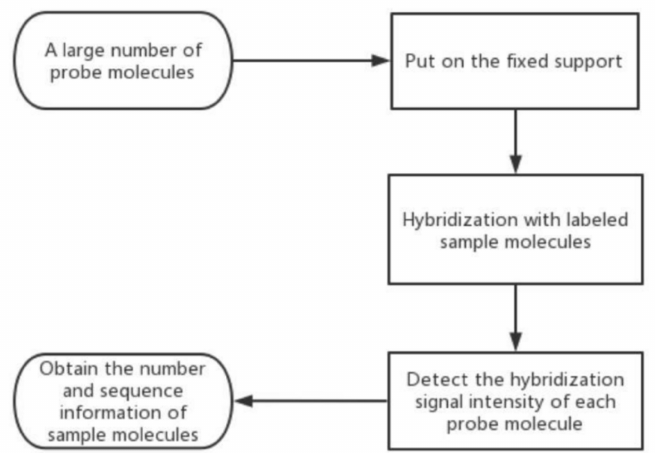
Figure 3. The schematic diagram of GC. At first, we need to collect a large number of probe molecules. Secondly, we put them on the fixed support, and hybridize them with labeled sample molecules. Thirdly, we should detect the hybridization signal intensity of each probe molecule. At last, we can obtain the number and sequence information of sample